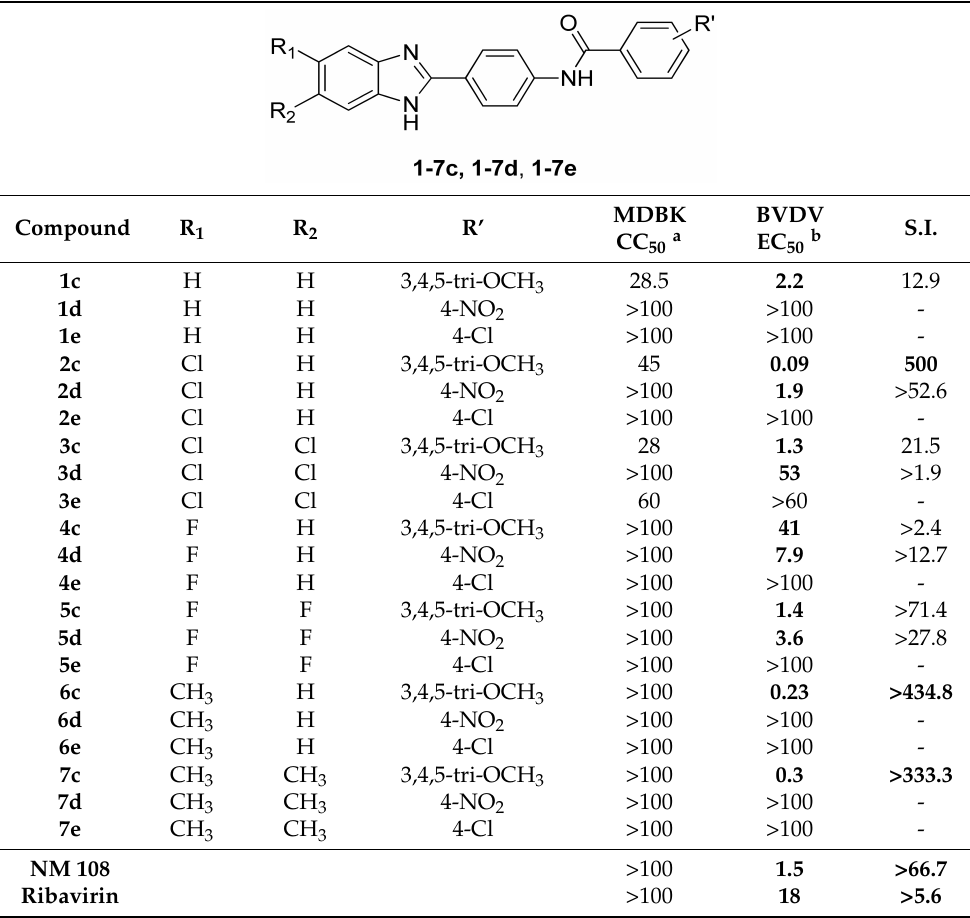
Table 1. Antiviral activity and cytotoxicity of benzimidazole derivatives ( 1 – 7c , 1 – 7d , 1 – 7e ); NM108 and ribavirin were used as positive